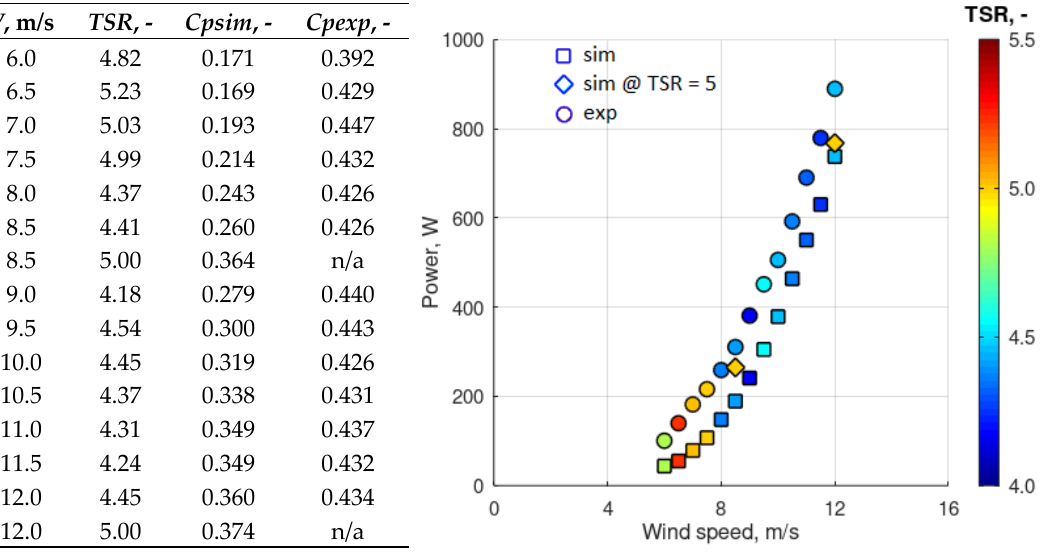
Figure 4. Analyzed cases and power obtained at different wind speeds and Tip ‐ Speed Ratio (TSR) .